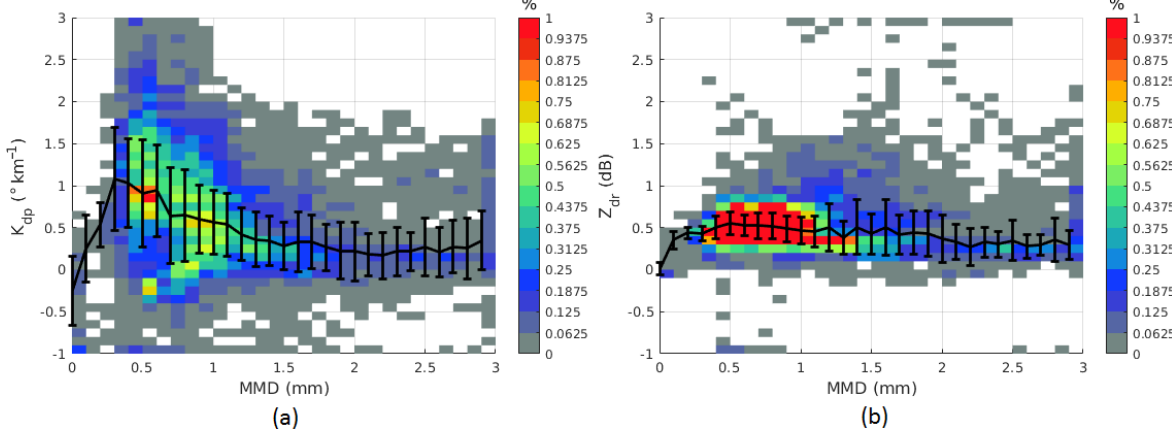
Figure 8. K dp (a) and Z dr (b) as functions of median mass diameter (MMD). Over 17000 data points from seven selected flights (Sect. 6) during the Cayenne campaign are